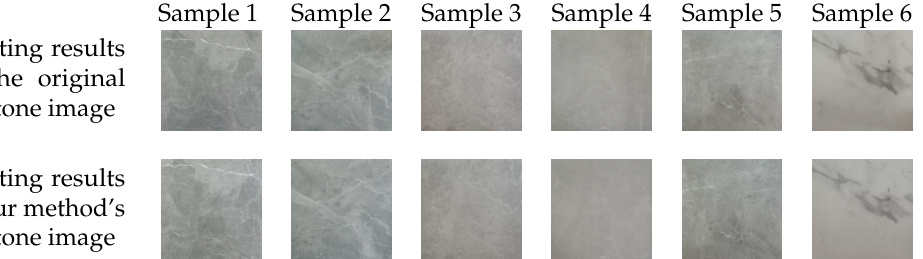
Figure 11. Comparison of the results of the original halftone image and the halftone image generated by our